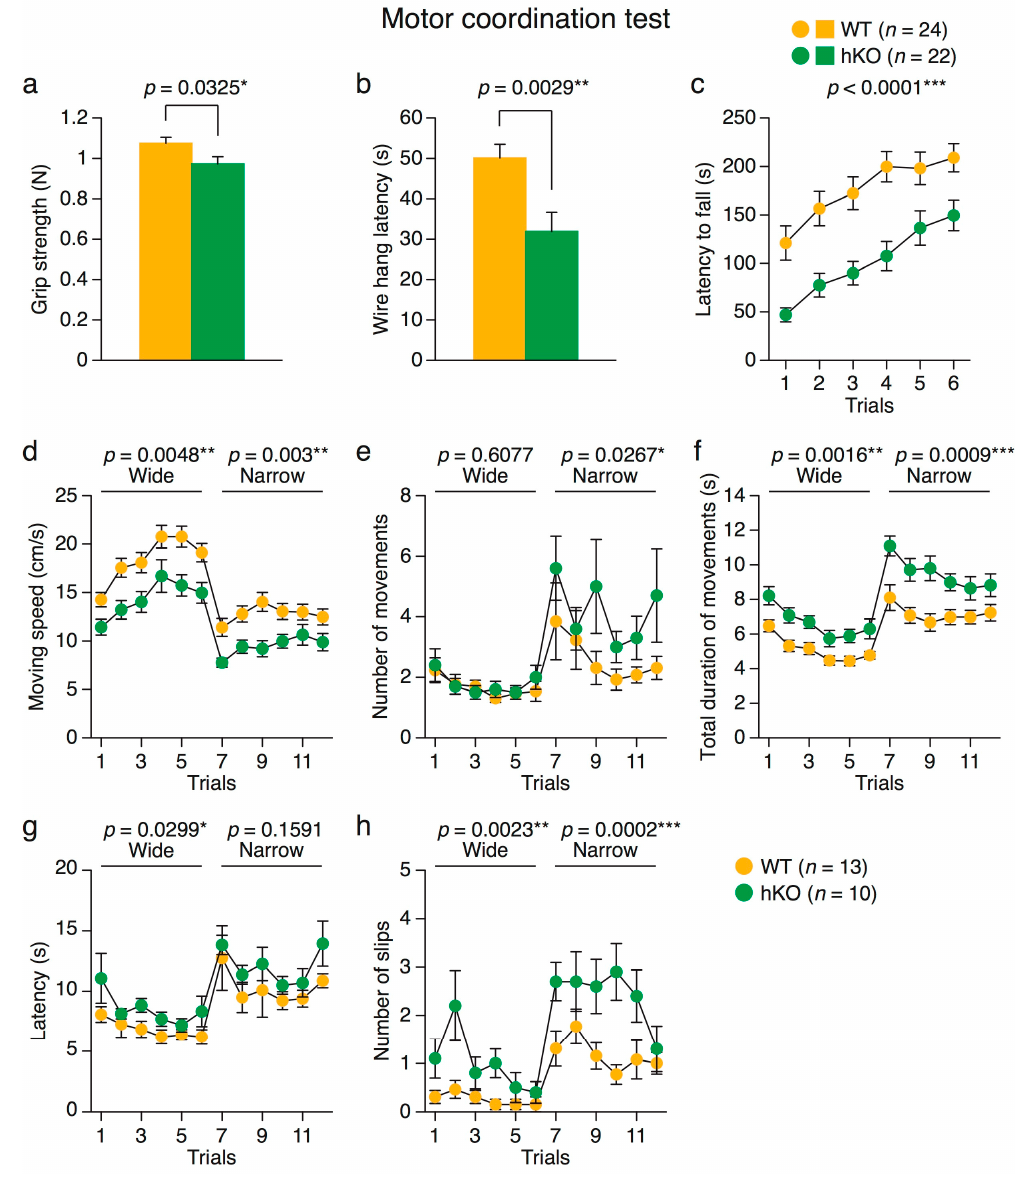
Figure 2. Muscular strength and motor coordination in Arid1b hKO mice. ( a ) Forelimb grip strength; ( b ) latency of falling from the wire mesh in the wire hang test; ( c ) latency of falling from the rotarod (WT, n = 24; Arid1b hKO, n = 22); ( d – h ) beam test; ( d ) movement speed; ( e ) number of movements; ( f ) total duration of movements; ( g ) latency of crossing the beam; ( h ) number of slips. (WT, n = 13; Arid1b hKO, n = 10). Mice falling off the beam in the beam test were excluded from the analysis. Significant differences between genotypes are indicated by * p < 0.05 and ** p < 0.01, *** p < 0.001 as determined by Student’s two-tailed t -test ( a , b ) or two-way repeated-measures ANOVA ( c – h ).